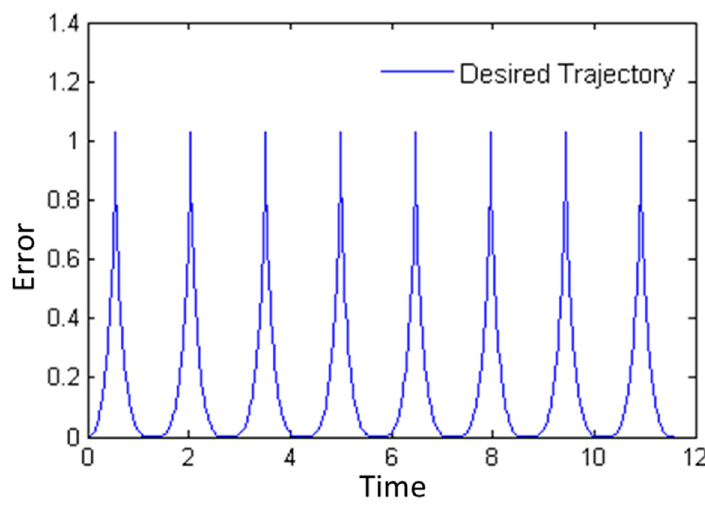
Figure 11. Desired trajectory for the autonomous mobile robot [39].